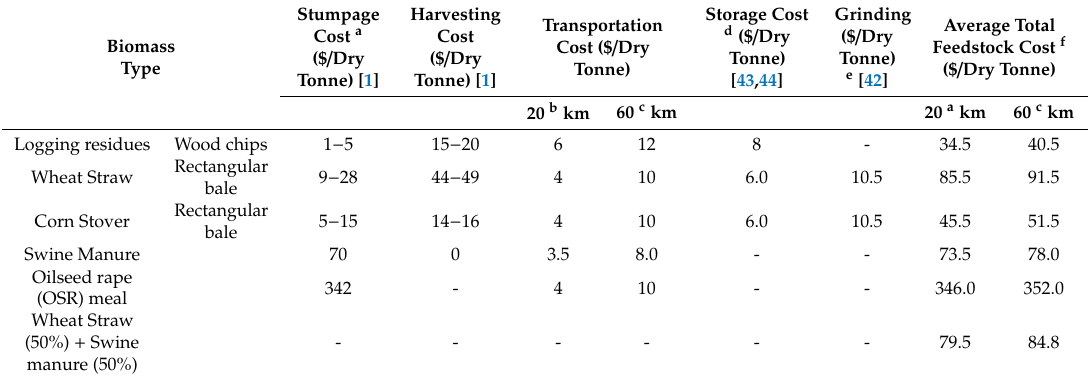
Table 1. Logistics costs of biomass for the small-scale portable biofuel